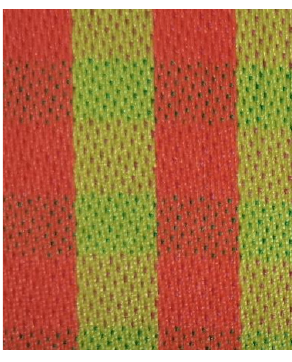
Figure 5. Satin fabric.